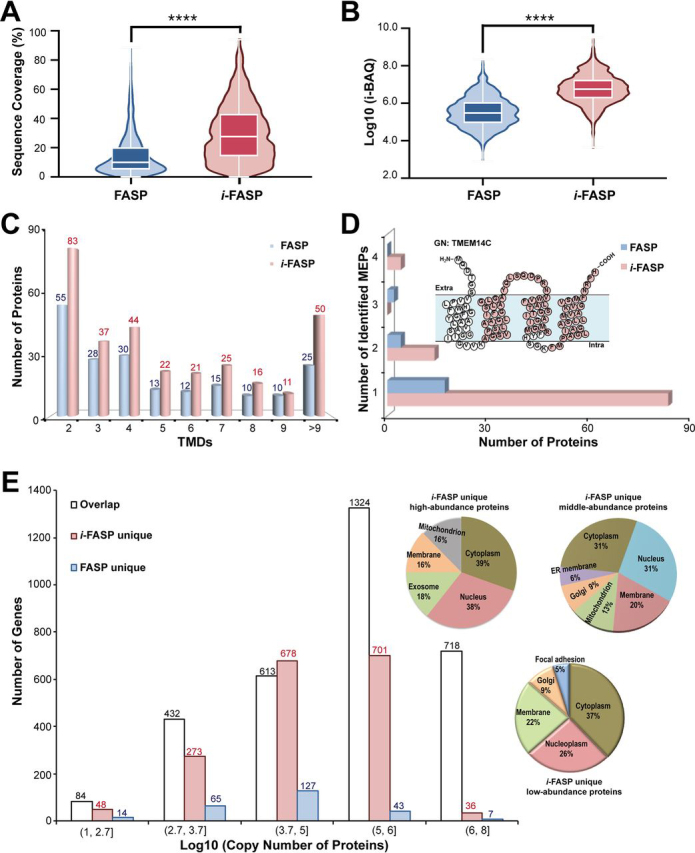
Qualitative proteome analysis results for 103 HeLa cells. A comparison of (A) the abundance and (B) sequence coverage of commonly identified proteins from a 1000-cell sample prepared using the i-FASP and FASP methods; ****p < 0.0001 between i-FASP and FASP methods with two-tailed, Wilcoxon test. The distribution of (C) transmembrane domains (TMDs), (D) membrane-embedded peptides (MEPs) and (E) copy number of the proteins identified from the 1000-cell sample prepared using the i-FASP and FASP methods. Additionally, (D) the topology of the TMEM14C, including the four MEPs (red labeled amino acids) exclusively identified with i-FASP method, is shown in the inset. (E) The distribution of cellular component of the high-, middle- and low-abundance proteins uniquely identified with i-FASP method is shown in the inset.